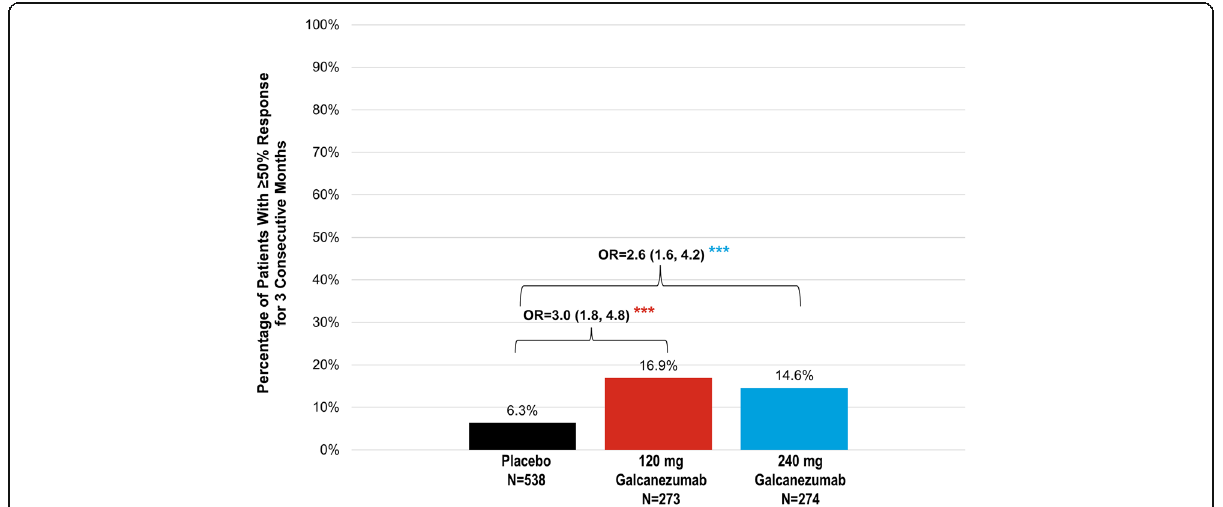
Fig. 2 Chronic migraine: proportions of patients with maintenance of ≥ 50% response for 3 consecutive months. Abbreviations: OR = odds ratio. *** = p <